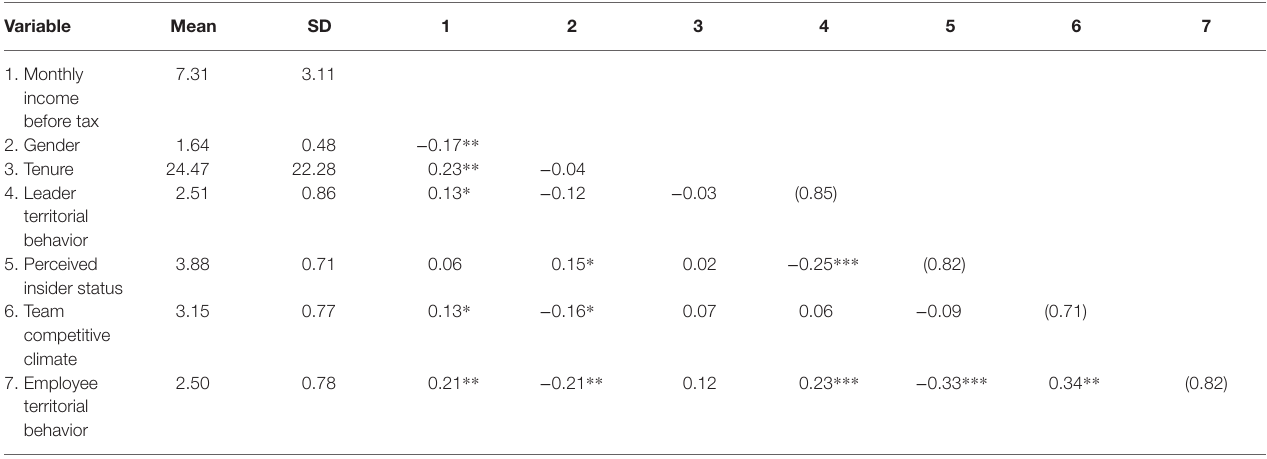
TABLE 1 | Means, standard deviations, and correlations among variables.